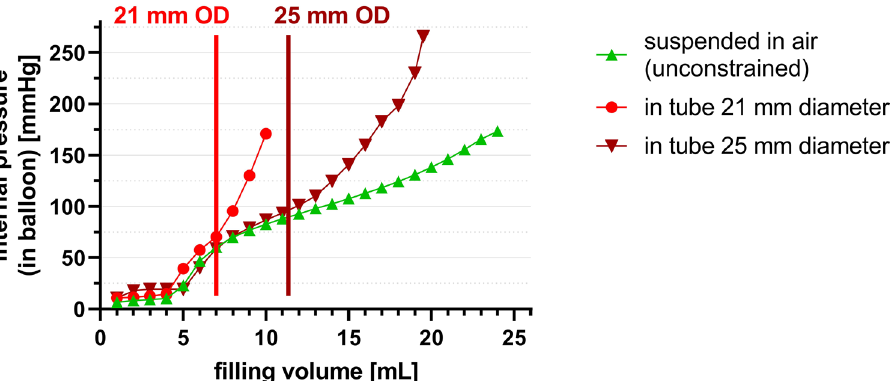
Figure 4. Differences in internal pressure (within the balloon) while inflated in air (unconstrained; green line), or in silicone tubes of 21-mm or 25-mm diameter in static conditions. Once balloon diameter reaches the inner diameter of the tube, internal pressure rises sharply. OD = outer